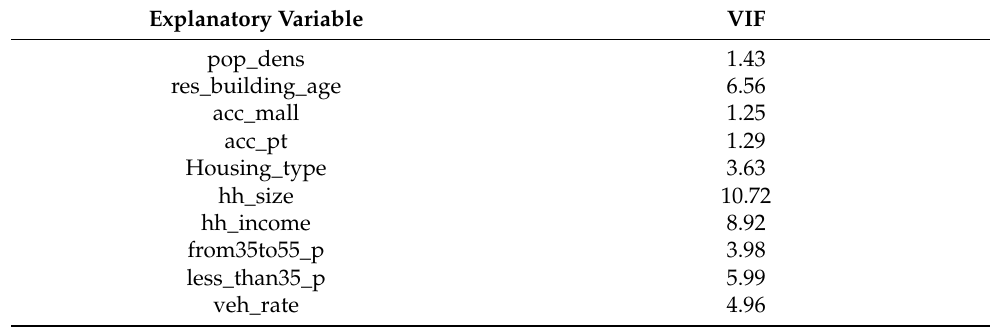
Table 3. Variance inflation factors of explanatory